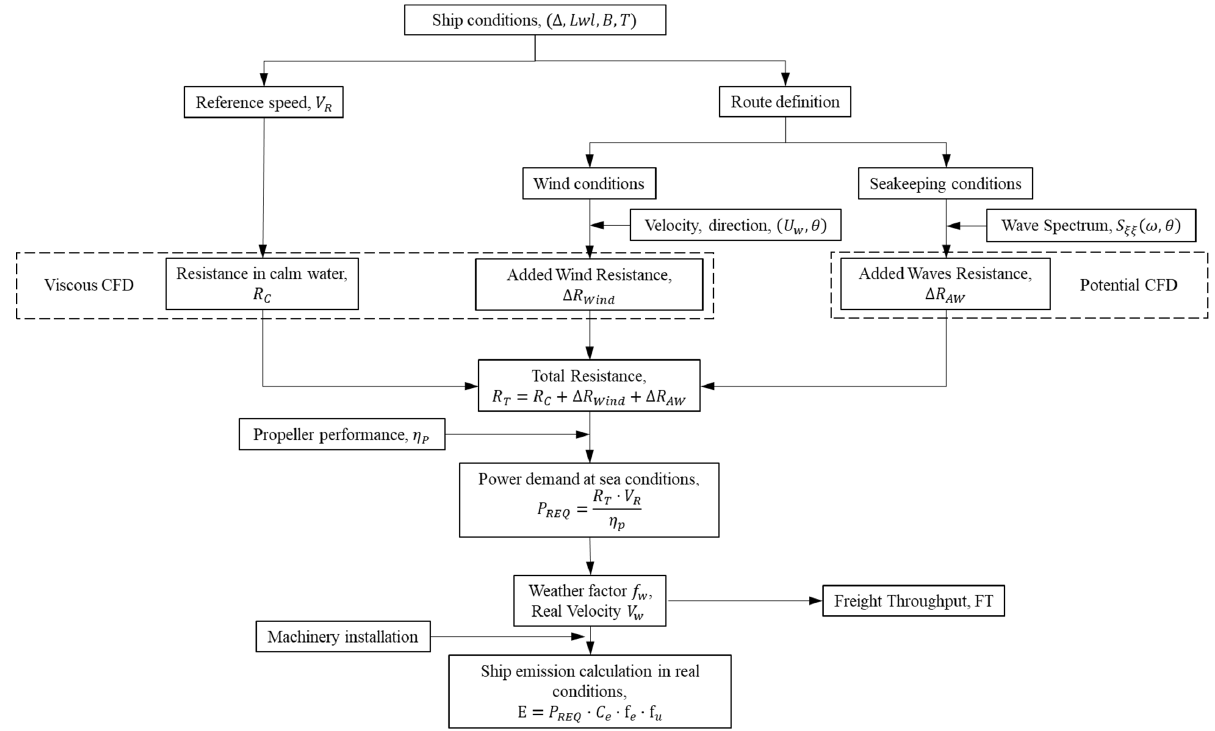
Figure 1. Methodology to value the increase in ship emissions in real operational conditions. Source: own elaboration adapted from International Towing Tank Conference (ITTC) guidelines [20].